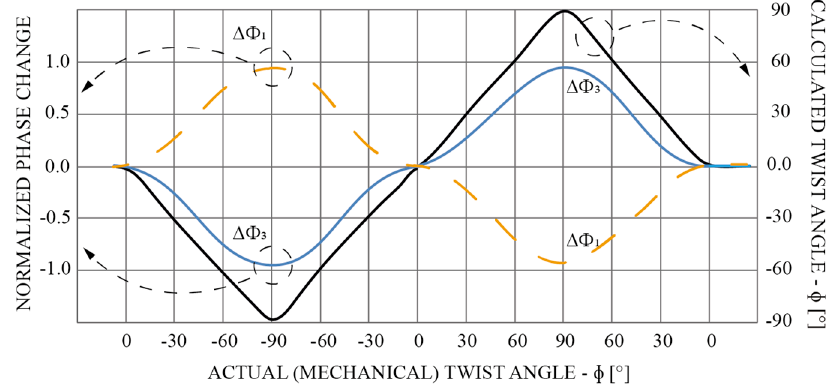
Figure 8. Calculated twist/rotation angle from diametrically opposite FPIs` phases measurement. The dashed yellow curve and blue curve represent normalized phase change of diametrically opposite FPIs, and the black curve represents the calculated twist angle.